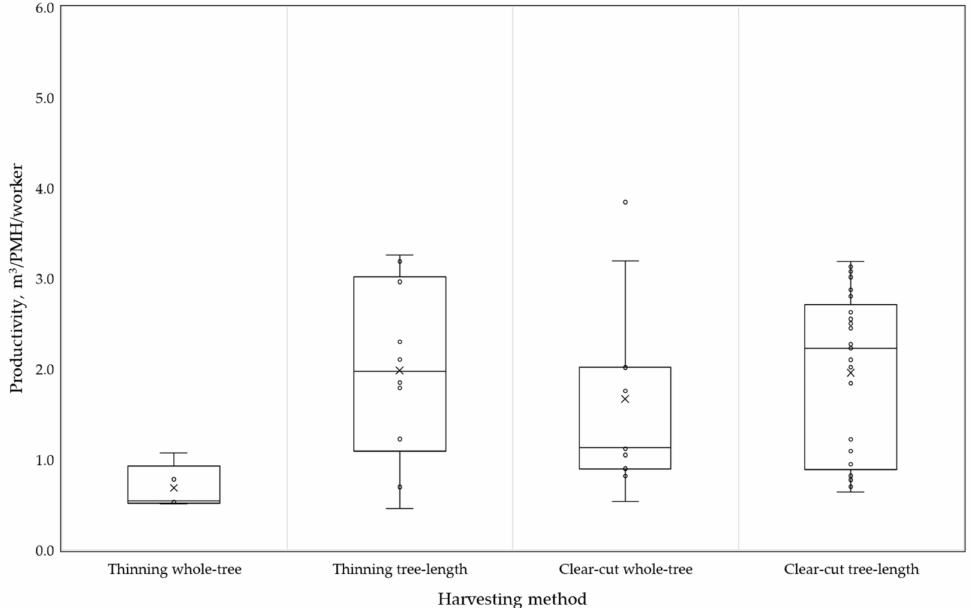
Figure 3. Changes in productivity evaluated for whole-tree and tree-length harvesting methods between two different silvicultural treatments: mean yarding distances of 54 and 69 m in thinning, and 70 and 72 m in clear-cut, respectively. The circles are data points, and the × is the mean